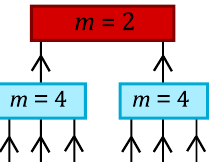
FIG. 16. Connectors for entanglement detection. Six-qubit entanglement witness W 6 resulting from the composition of witness (41) with m ¼ 2 and m ¼ 4